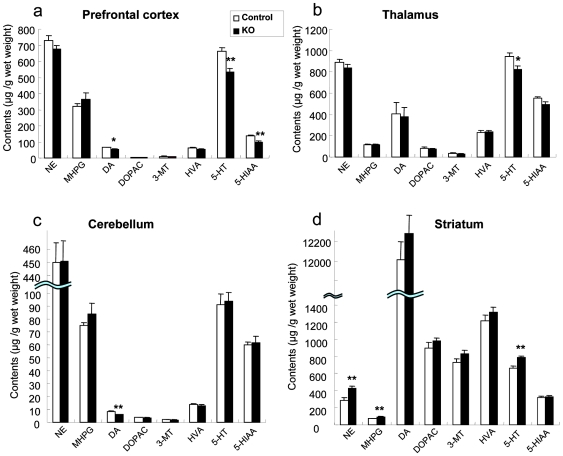
Tissue monoamine levels of individual brain regions.Levels of monoamine neurotransmitters and their major metabolites were assayed in the (a) prefrontal cortex, (b) thalamus, (c) cerebellum, and (d) striatum of controls (n = 11) and HB-EGF KO (n = 11) mice. Values are means±SEM. * p<0.05, ** p<0.01 vs. control mice. NE: Norepinephrine, MHPG: 3-methoxy 4-hydroxy phenethyleneglycol, DA: Dopamine, DOPAC: 3,4-dihydroxyphenilacetic acid, 3-MT: 3-methoxytyramine, HVA: homovanillic acid, 5-HT: Serotonin, 5-HIAA: 5-hydroxyindol acetic acid.